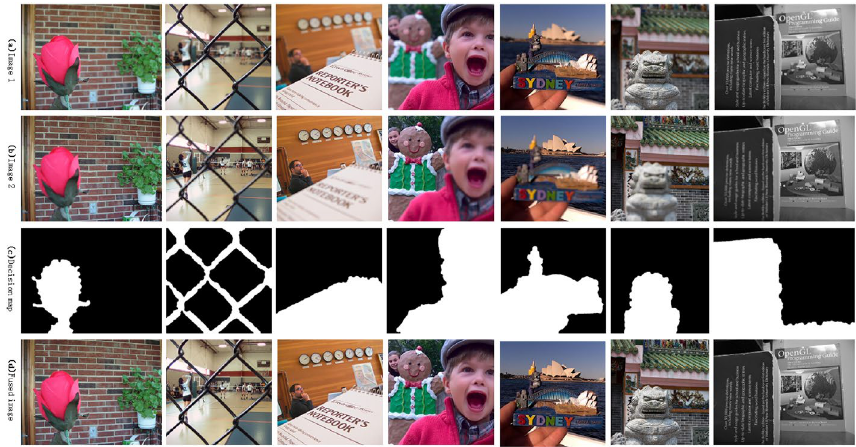
Figure 2. Fusion image results 35,36 .